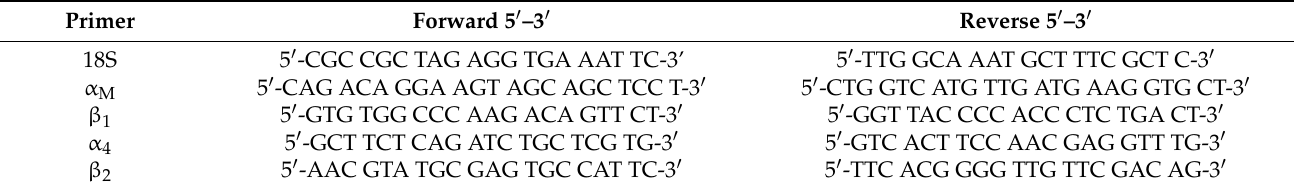
Table 1. Sequences of primers used for gene expression